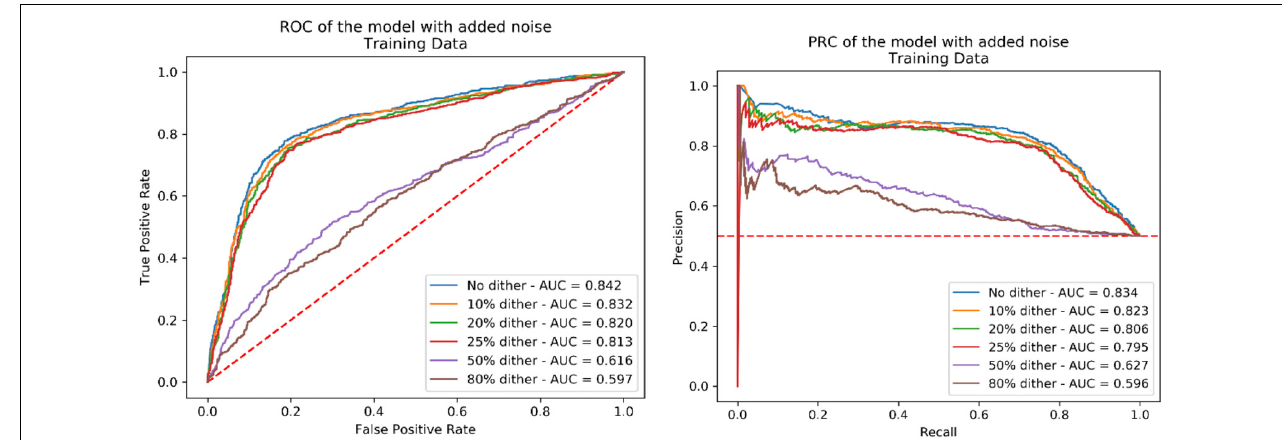
FIGURE 4 | The ROC (left) and PR (right) curves computed on the training data set. The AUC values are in the legend. The dashed lines in both graphs indicate the performance of a randomly guessing classifier.